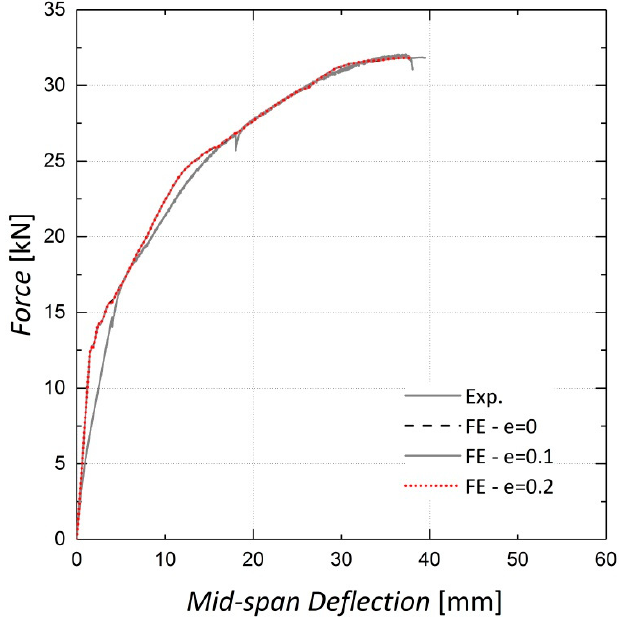
Figure 10. Sensitivity of results to eccentricity—Beam 10.